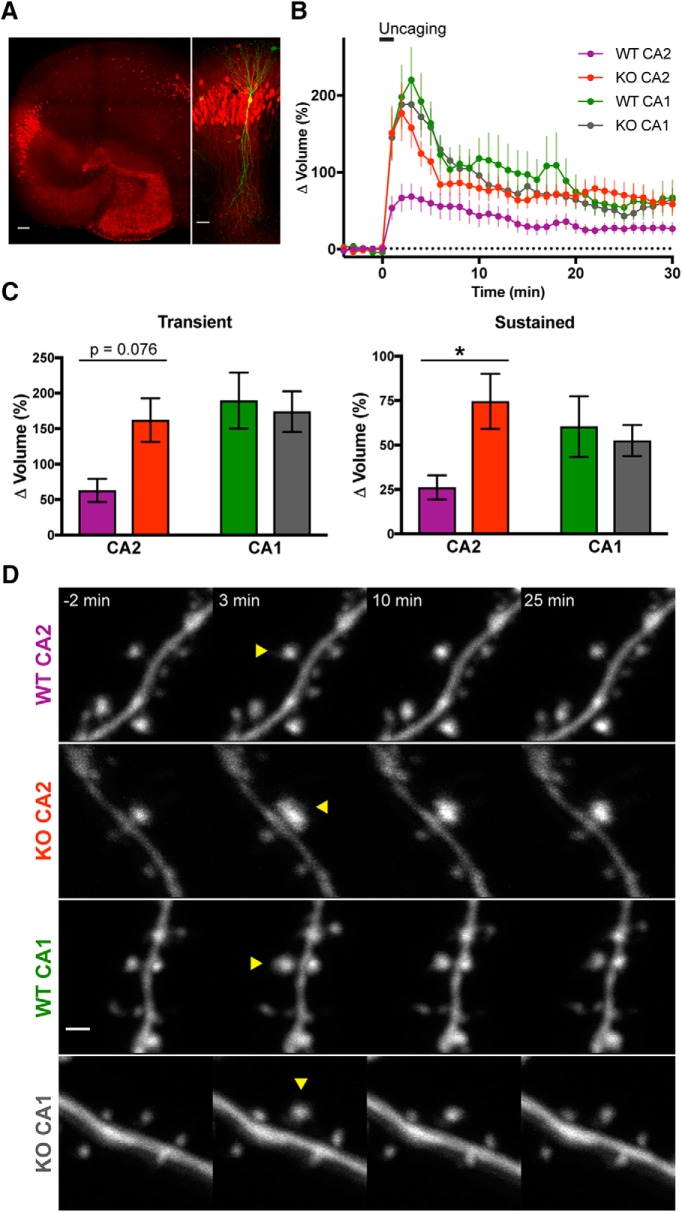
RGS14 suppresses CA2 spine structural plasticity. A, Representative post hoc immunostaining to delineate hippocampal region CA2 region after imaging biolistically transfected neurons. Left: Organotypic hippocampus slice culture stained for the DG- and CA2-enriched gene PCP4 (red). Scale bar = 100 µm. Right: Magnified view of area CA2 in PCP4 immunostained (red) hippocampus on left with a biolistically labeled CA2 pyramidal neuron expressing mEGFP (green). Scale bar = 50 µm. B, Averaged time course of spine volume change during the induction of spine structural plasticity (sLTP) by repetitive two-photon glutamate uncaging (top bar; 30 pulses at 0.5 Hz) in the absence of extracellular Mg2+. The number of samples (spines/neurons/animals) for stimulated spines are 19/6/5 for WT CA2, 15/8/6 for KO CA2, 23/7/5 for WT CA1, and 16/6/5 for KO CA1. Sample size applies to B and C. Error bars denote SEM. C, Quantification of the average volume change for stimulated spines during the transient (1–3-min) and sustained (21–25-min) phases of sLTP induction. Sidak’s, *, p < 0.05. D, Representative two-photon fluorescence images of dendritic spines during sLTP induction in mEGFP-expressing hippocampal pyramidal neurons. Arrowheads indicate location of glutamate uncaging. Scale bar = 1 µm.